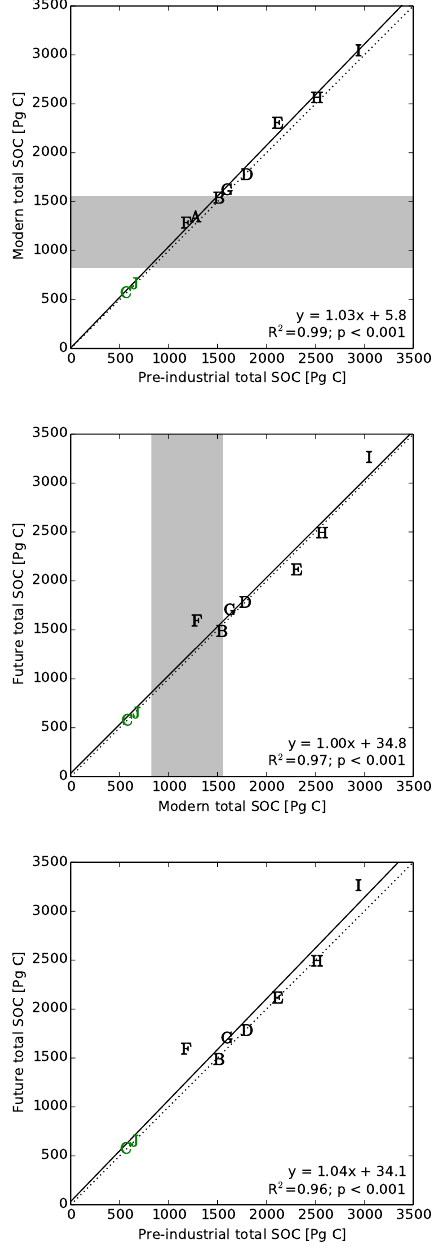
Figure 1. Relationship between total SOC in CMIP5 models at two different times: modern stocks as a function of pre-industrial stocks (upper panel), future stocks as a function of modern stocks (mid- dle panel) and future stocks as a function of pre-industrial stocks (lower panel). Letters correspond to models as in Table 1 and mod- els in green (i.e. C and J) integrate nitrogen limitation. The grey area is the 95% confidence interval of modern total SOC derived from the HWSD. Equation, R 2 and p values correspond to the linear re- lationship between stocks built using data from all models (solid line). The dotted line is the 1 : 1 line.